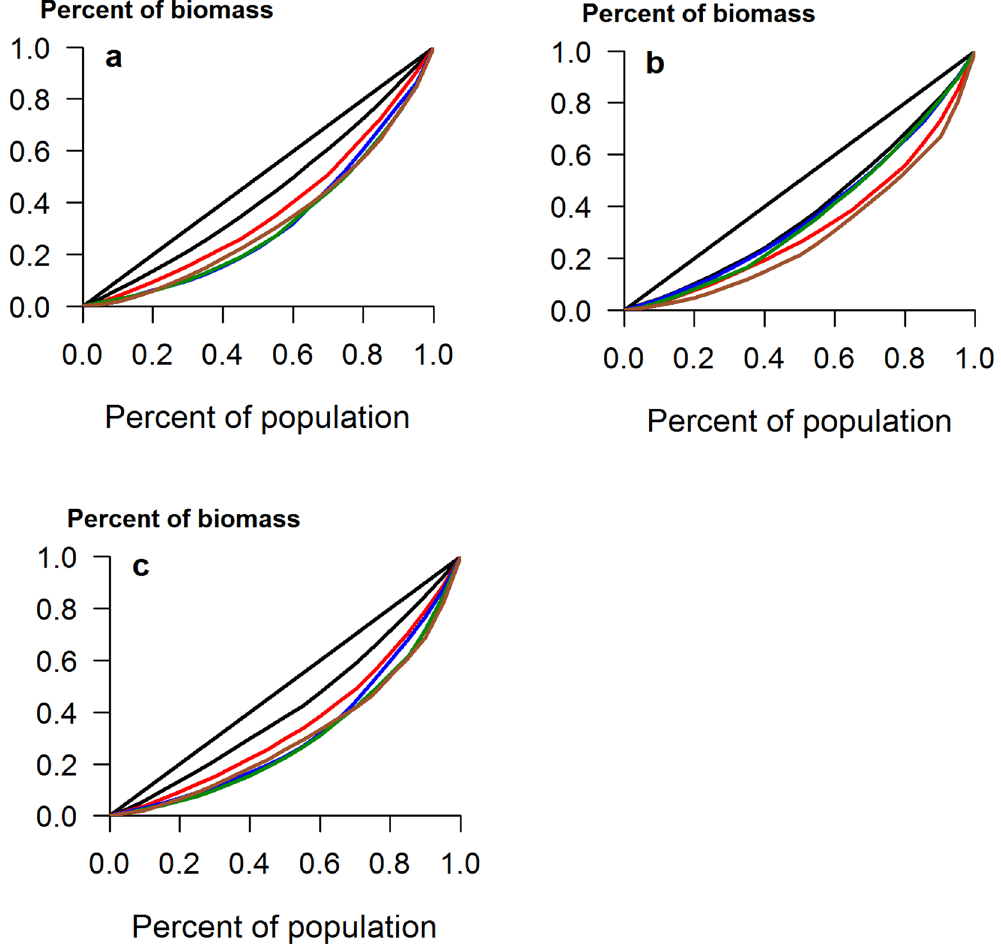
Figure 4. Lorenz curves for ( a ) total biomass, ( b ) root biomass and ( c ) shoot biomass of calabrese plants grown in UK field soil. The diagonal straight line represents the line of equality. Control plants depicted in black, B . amyloliquefaciens addition in green, B . cereus addition in red, B . subtilis addition in blue and the mixed inoculum in